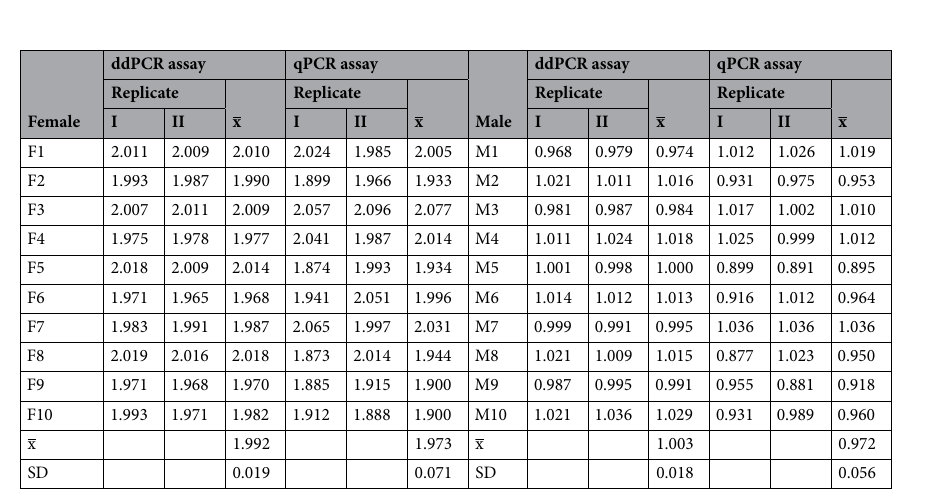
Table 2. Summary of results of ddPCR and qPCR in the collection A.